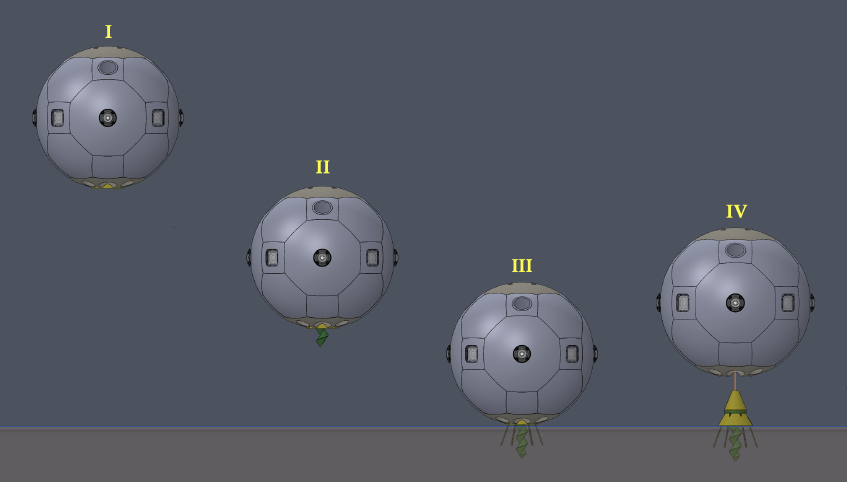
Figure 2. The RAATM, installed within the WIEVLE, executing the anchoring sequence from the stowed to the tethered positions.